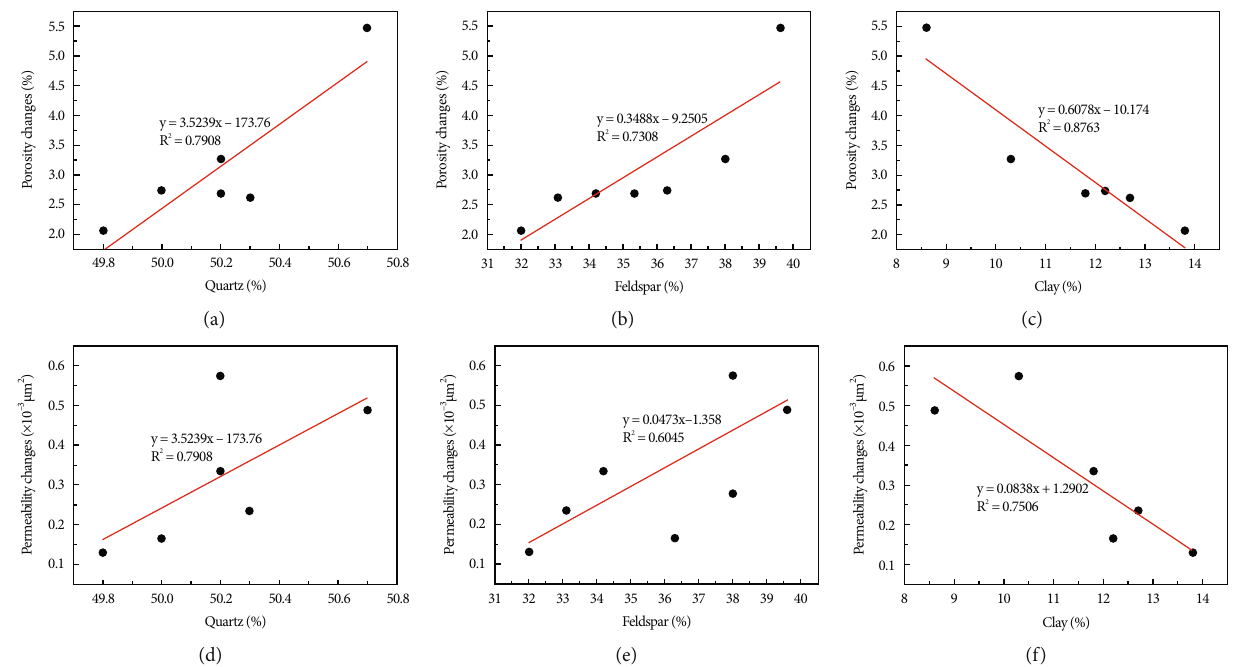
Figure 11: Relationship between quartz, feldspar, and clay content with the changes of porosity and permeability. (a – c) The content of quartz, feldspar, and clay with the porosity changes, respectively; (d – f) the content of quartz, feldspar, and clay with the permeability changes,